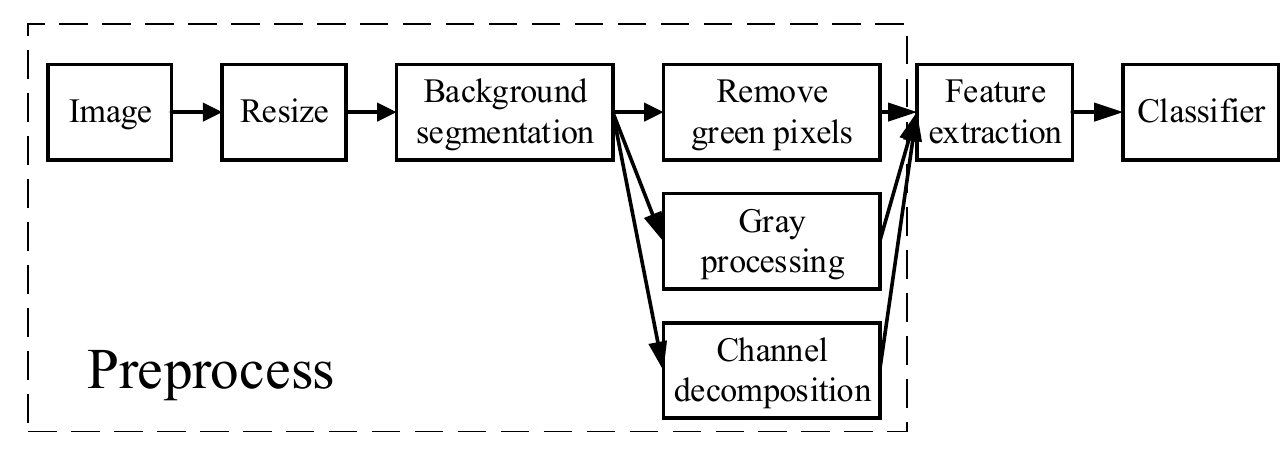
( j ) TYLCV Figure 2. Examples of tomato images from PlantVillage dataset. ( a ) ( b ) Figure 3. Dataset clustering results based on t-SNE. We can see from ( a , b ) that there is a spatial distance between different clusters (diseases), thus proving that the dataset is divisible. As shown in Figure 4, besides image augmentation, we used various other image pre-processing